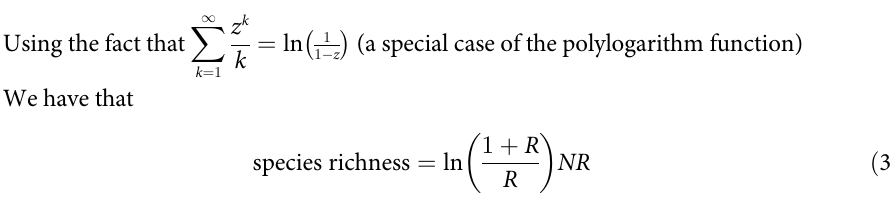
Table 1. Hybrid model estimates of rate of infectious spread estimates and ratio of infectious to mitotic spread by patient. Patient (Disease